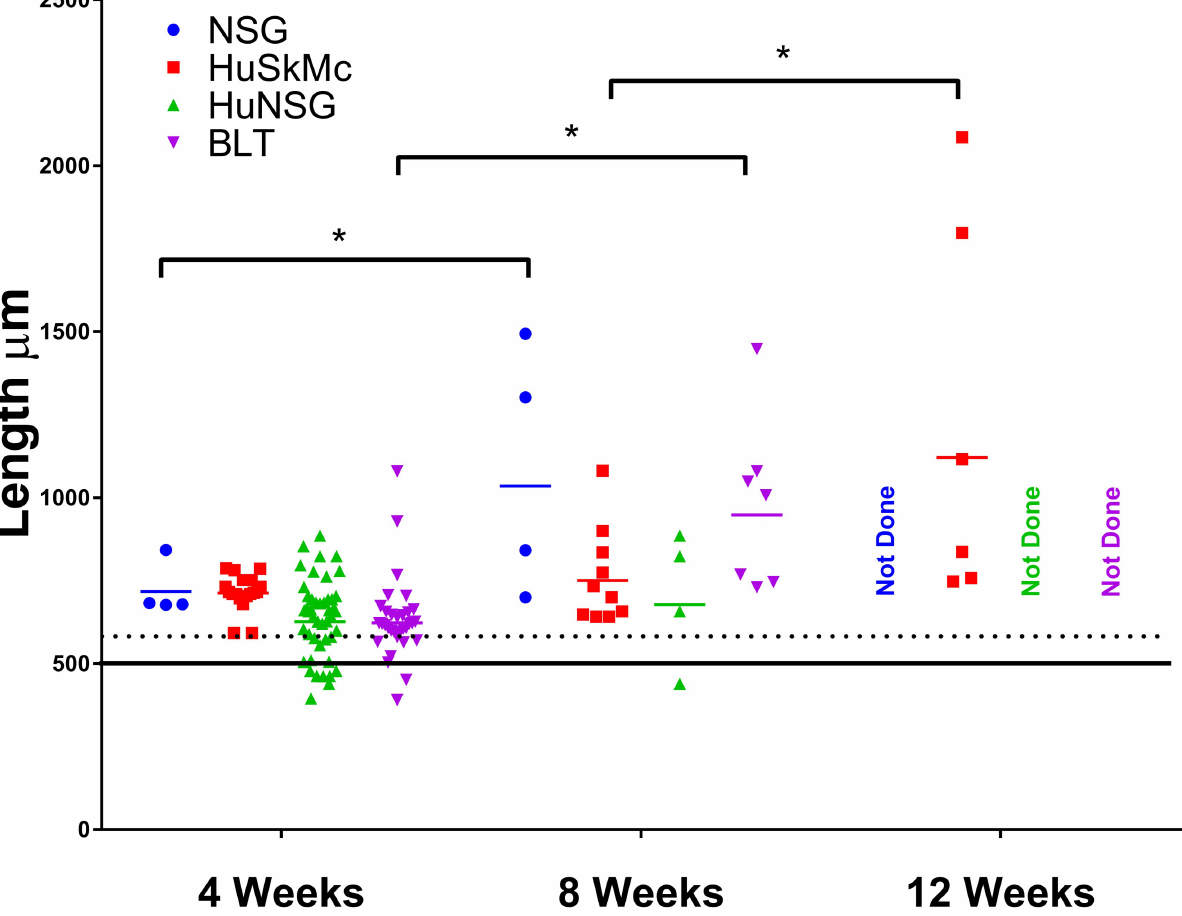
Fig 2. Growth of larval Onchocerca volvulus in four mouse models. O. volvulus L3 (100/mouse) were injected subcutaneously into 4 different NSG based models: (1) NSG, (2) Human skeletal muscle cell engrafted NSG mice (HuSkMc), (3) Humanized NSG (HuNSG) mice: NSG mice that had received a human CD34 + stem cell transfer, (4) BLT: NSG mice that had been engrafted with human fetal liver derived CD34 + stem cells and engrafted with fetal thymus and liver tissues. After 4, 8 or 12-weeks, animals were necropsied and worms were recovered and measured. Solid colored bar is the geometric mean of the lengths of larvae recovered. Solid black line is the geometric mean of the length of L3 recovered from black flies and dotted line is the 95 th confidence interval. � Asterisk represents statistical difference, p value � 0.05, in length of larvae recovered from mice. Complete statistical analyses for all groups are included on S2